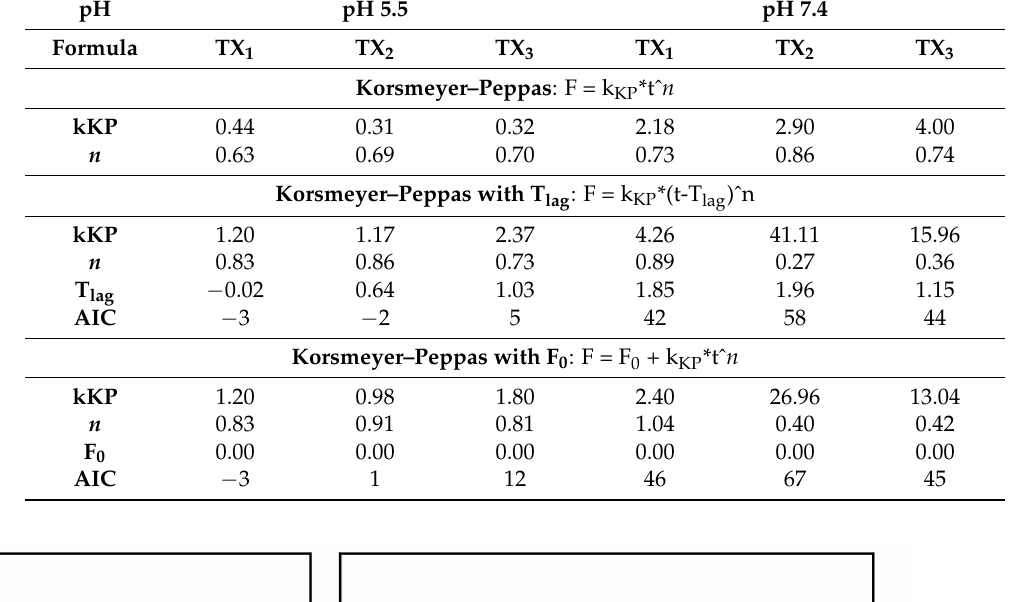
Table 4. The kinetic parameters “best-fit values” and “goodness of fit” for the dissolution profiles of the polymeric film with TX.